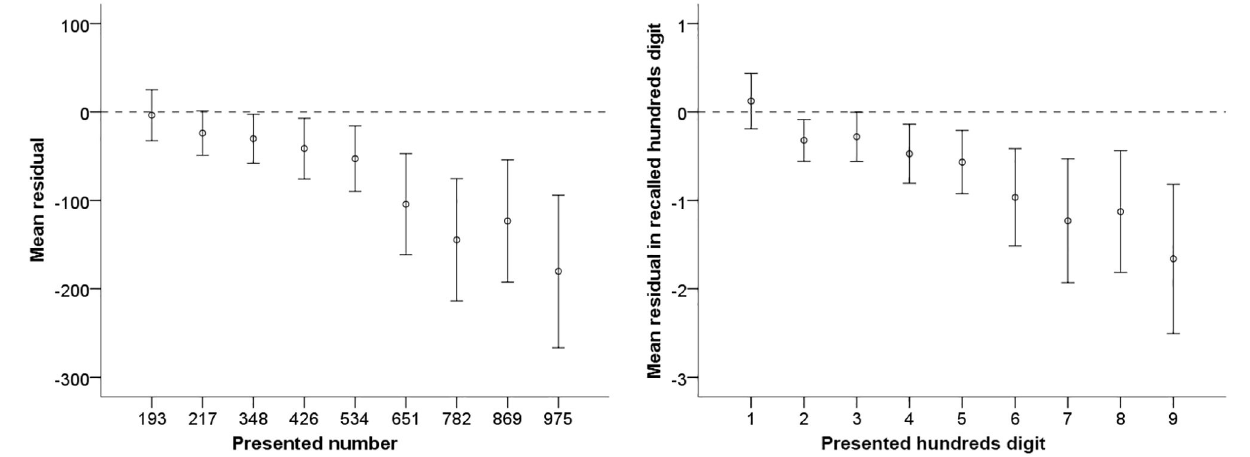
Figure 3. 95% confidence intervals for mean residuals (left) and mean residuals in the leading digit (right) in Study 2. Testing Predictions About the Relation Between the Standard Deviation of Residuals and Other